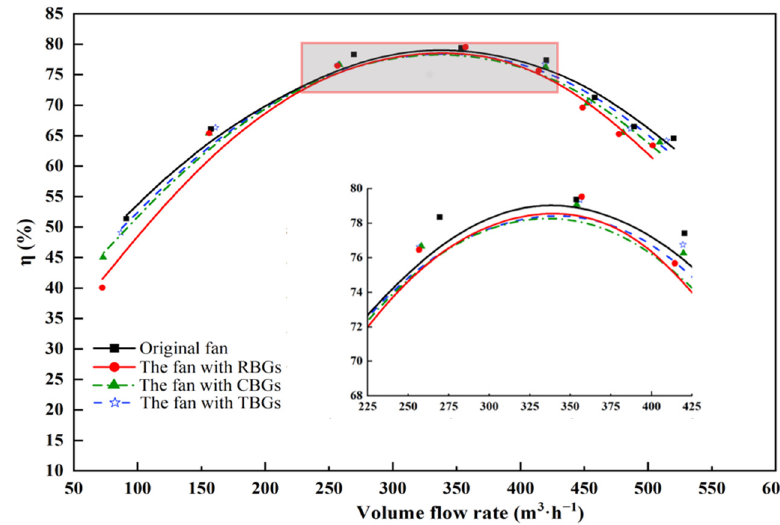
Figure 13. Comparison of η –Q curve between original fan and that with bionic groove.